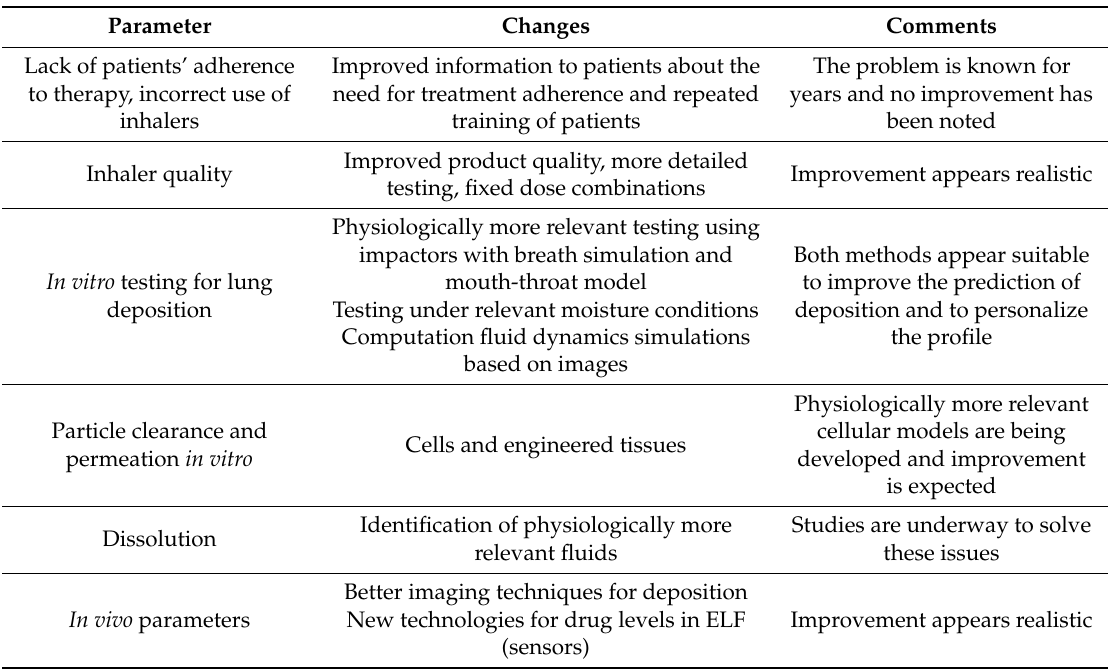
Table 1. Expected changes in current problems with in vitro-in vivo correlation (IVIVC) in pulmonary drug